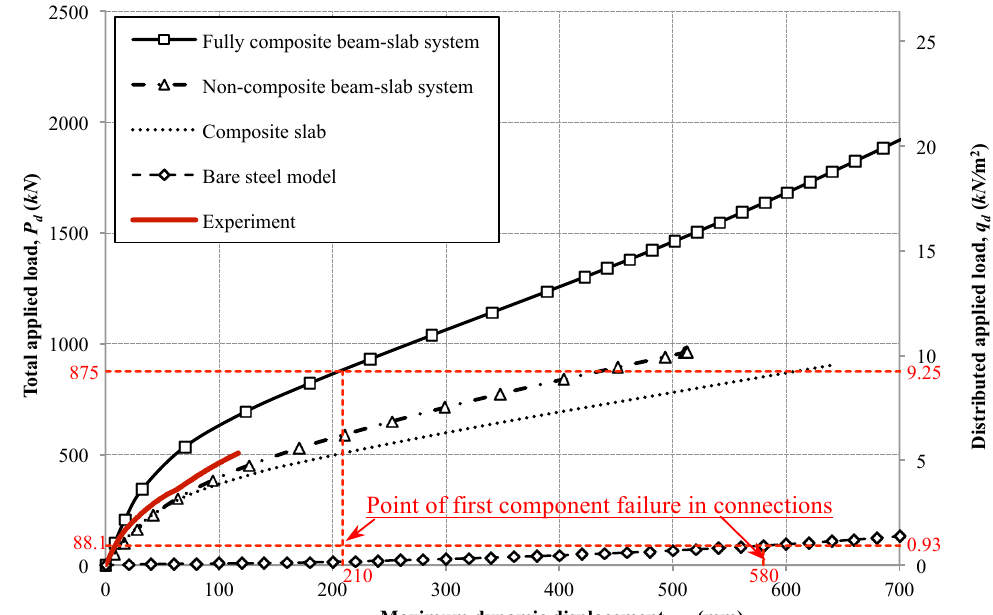
Figure 15. Pseudo-static response of examined floor systems under UDL